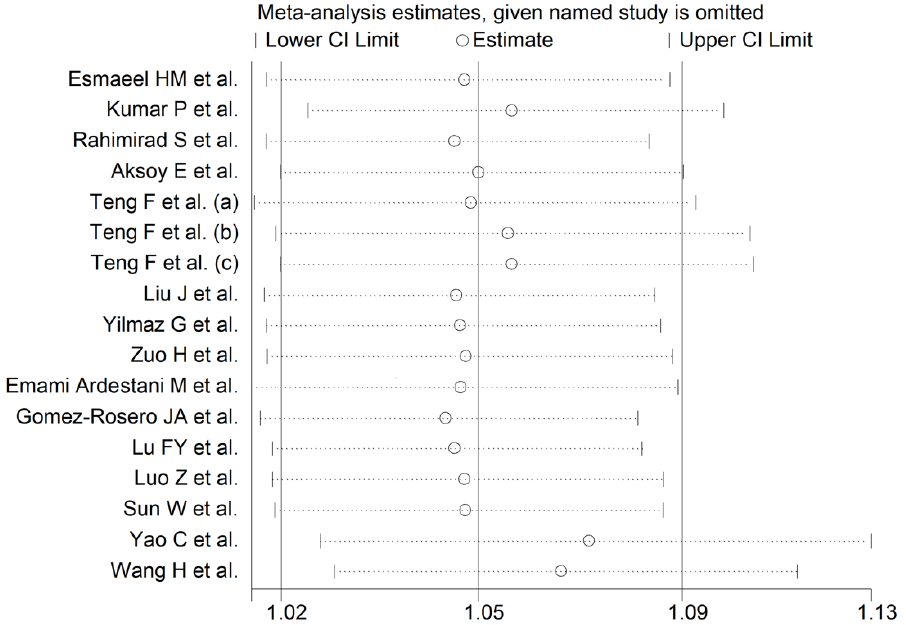
Figure 3. Sensitivity analysis showing the influence of individual studies on the overall odds ratio. The middle vertical axis indicates the overall odds ratio, and the two vertical axes indicate the 95% confidence intervals. The hollow circles represent the pooled odds ratio of the remaining studies when an individual study is omitted from the meta-analysis. The two ends of each broken line represent the 95% confidence intervals.